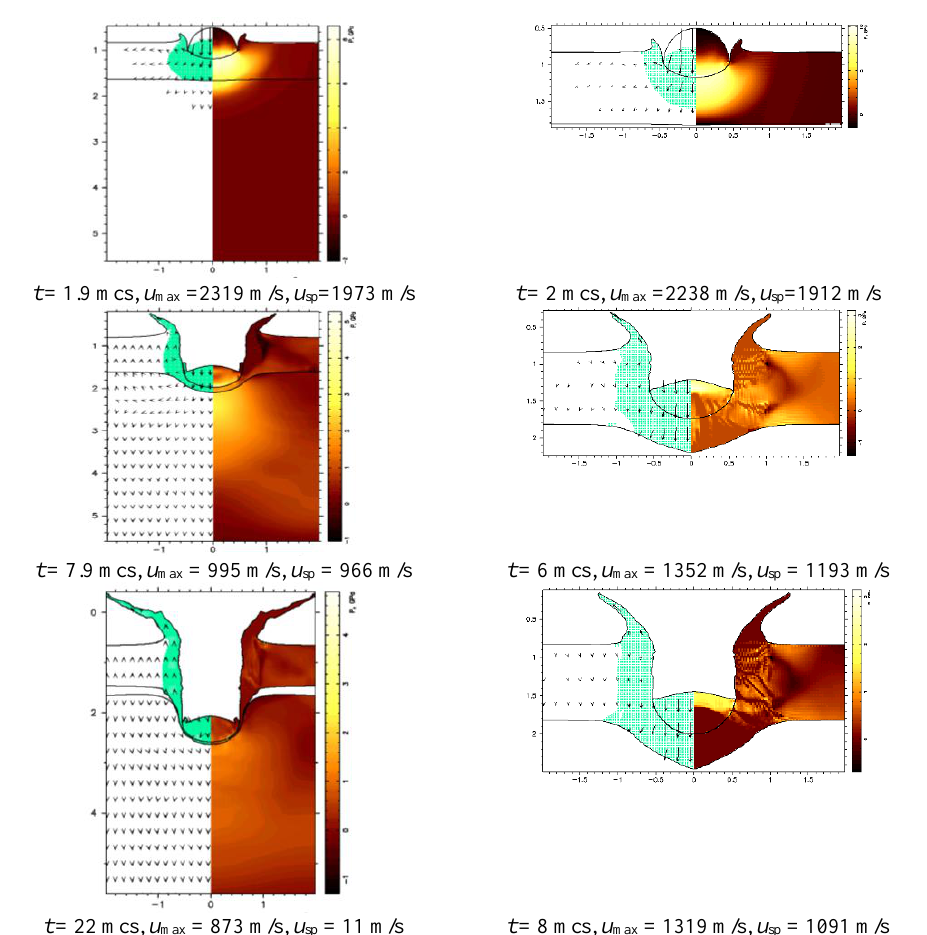
Fig 9. Chronogram of the interaction process of a steel spherical drummer with a Al 2 O 3 barrier The results are presented in the form of a velocity field with respect to the maximum velocity u max (left) and pressure field (right) in a cylindrical coordinate system x , z , (cm) at various points in time t of the interaction between the drummer and the obstacle. It also shows the values of the velocity of the drummer’s center of mass u max